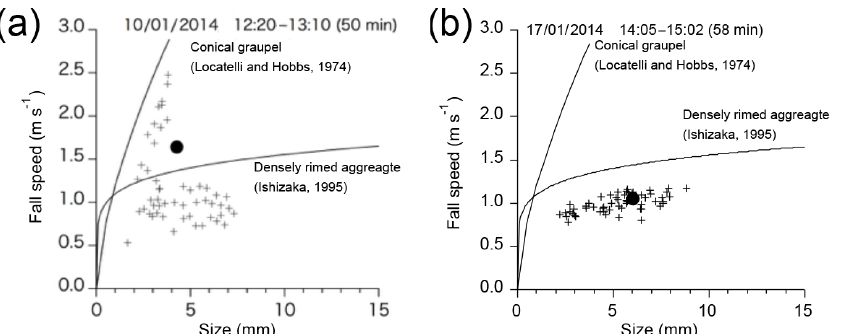
Figure 3. Distributions of 1min CMF (crosses) and the integrated CMF (filled circles) for two events: (a) an eliminated event; and (b) a selected event. The two curves represent size–fall speed relationships for conical graupel (from Locatelli and Hobbs, 1974) and densely rimed aggregate (from Ishizaka, 1995).